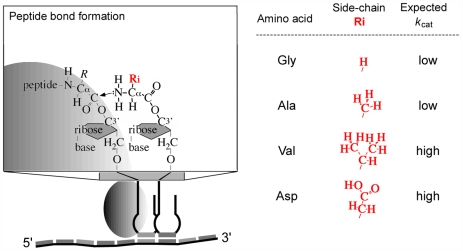
Amino acids side-chains and kinetics of peptide bond formation.Elementary translation and expected effect of the side-chains of alanine, glycine, aspartic acid and valine on the kinetics of peptide bond formation (k
cat) (discussed in the text).